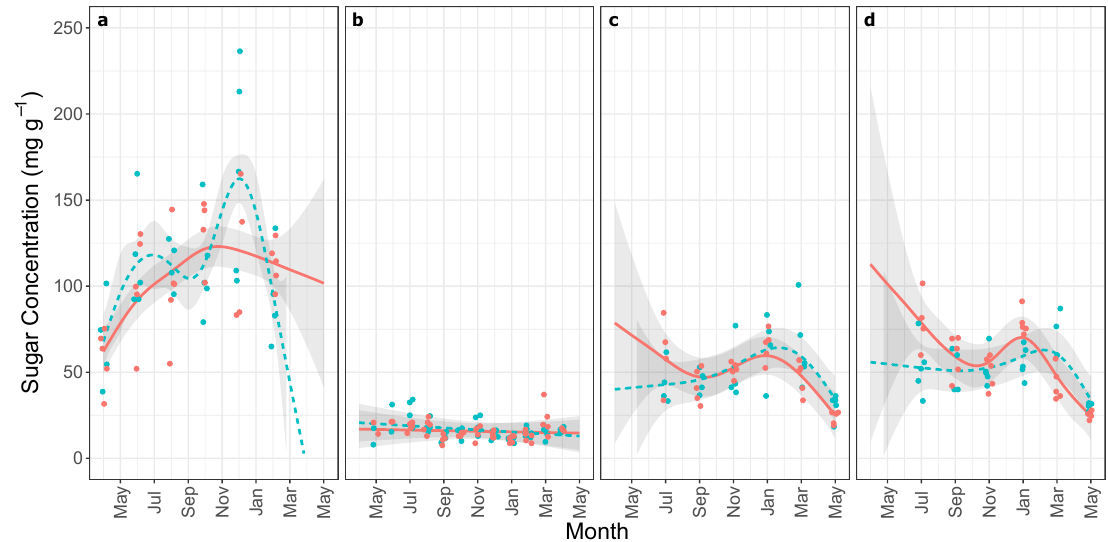
Figure 2. Mean soluble sugar concentrations (and 95% confidence band) from xeric (red solid) and mesic (blue dashed) populations of Pinus palustris collected between April 2013 and May 2014 from coarse lateral roots ( a ), stem at breast height ( b ), mid canopy branches ( c ), and upper canopy branches ( d ); estimated by generalized additive model (ten thin-plate regression splines using REML). For visibility, data points are jittered ± 0.2 months along the x-axis (jittering not used in